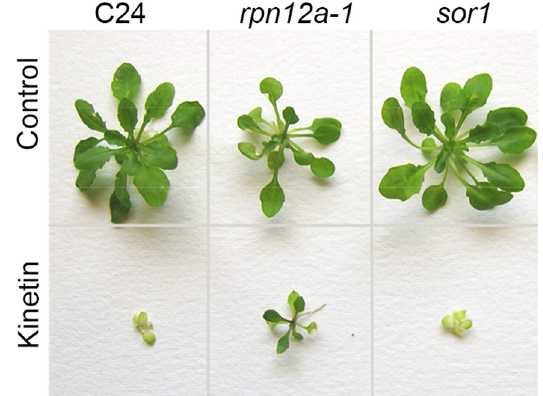
Figure 1. Decreased sensitivity of rpn12‑1 to cytokinins is restored by the sor1 mutation. Plants were grown for three weeks on MS/2 media (control) or MS/2 media containing 0.2 µM kinetin in continuous light. Representative seedlings are